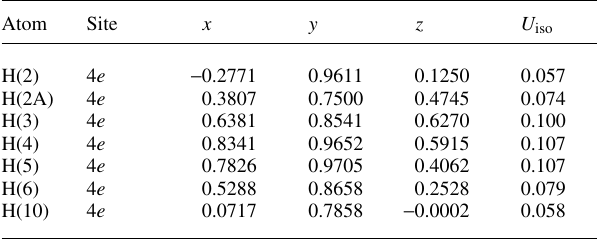
Table 2. Atomic coordinates and displacement parameters (in Å 2 )